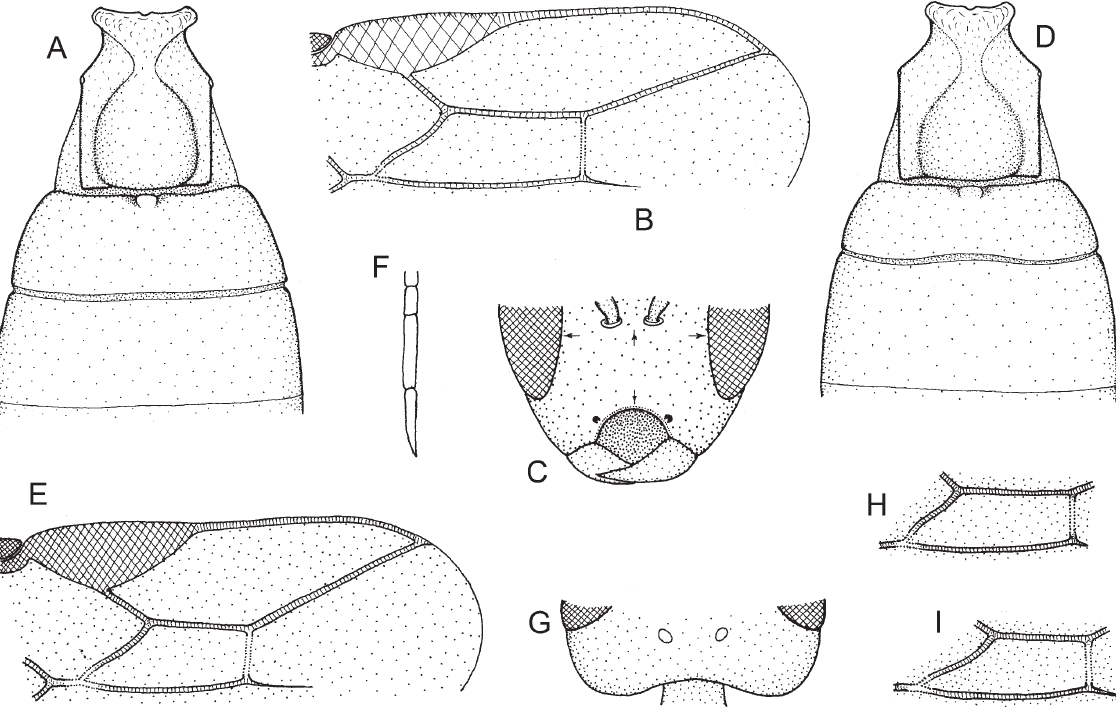
Fig. 56. — A-C . Bracon ( Palpibarcon ) mongolicus Telenga, 1936, ♀. A . Tergites 1-3. B . Distal part of right forewing. C . Head in frontal view. — D-F . Bracon ( Palpibracon ) tenuiceps Muesebeck, 1925, ♀. D . Tergites 1-3. E . Distal part of right forewing. F . Ultimate three segments of maxillar palp. — G-I . Bracon ( Palpibracon ) delibator Haliday, 1833 (G: ♀ / ♂, H-I: ♀). G . Hind half of head in dorsal view. H-I . First submarginal cell of right